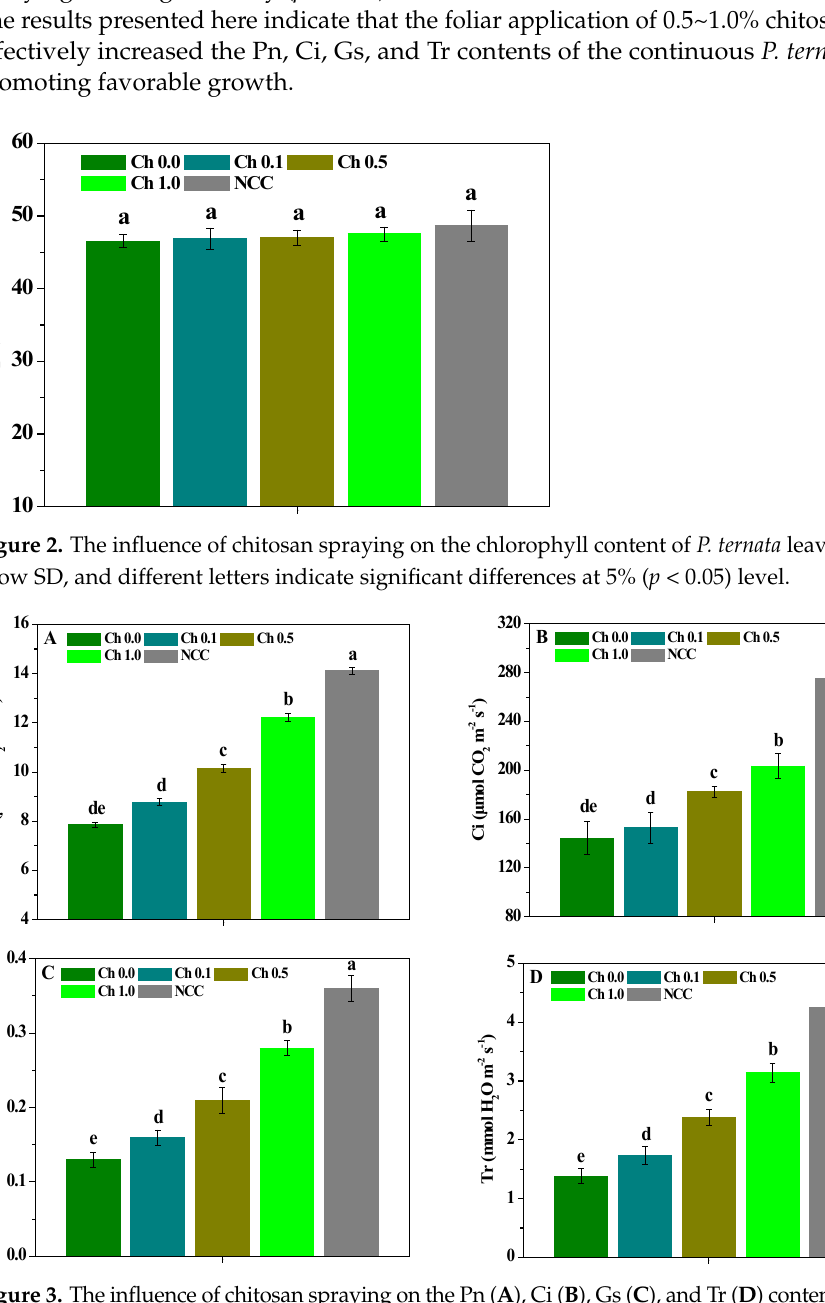
Figure 1. The influence of chitosan spraying on the inverted seedling rate of P. ternata . Error bars show SD, and different letters indicate significant differences at 5% ( p < 0.05) level.